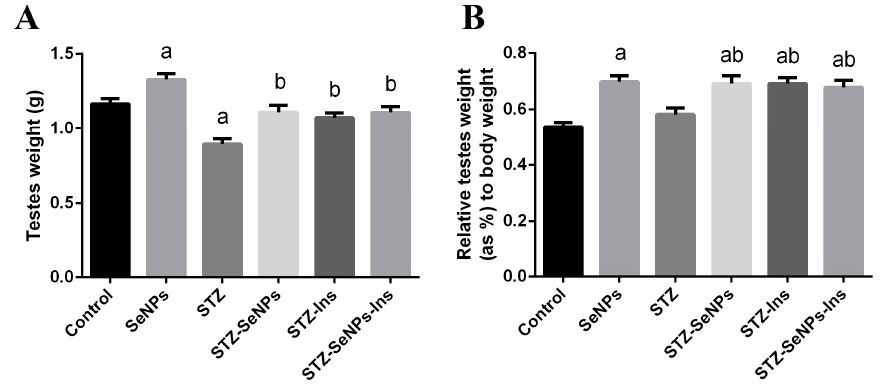
Figure 1. Impact of SeNPs and/or insulin on ( A ) the absolute and ( B ) relative weight of the testis in control and STZ-diabetic rats. The weight of rat testis and total body weights were measured over 28 days. Values are mean ± SEM ( n = 7). a p < 0.05, significant change with respect to Control group; b p < 0.05, significant change with respect to Diabetic group.